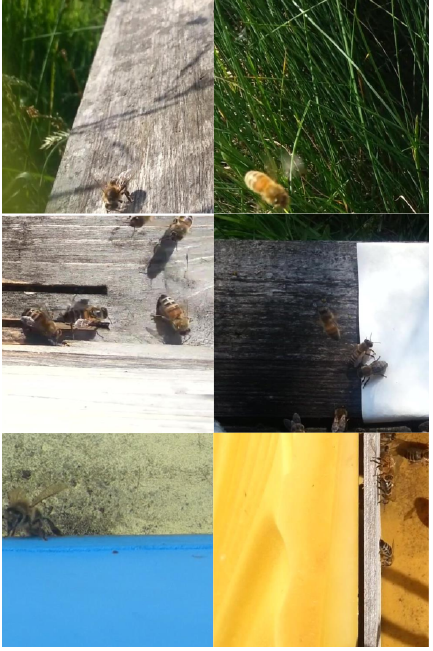
Figure 1. Sample images used as a training